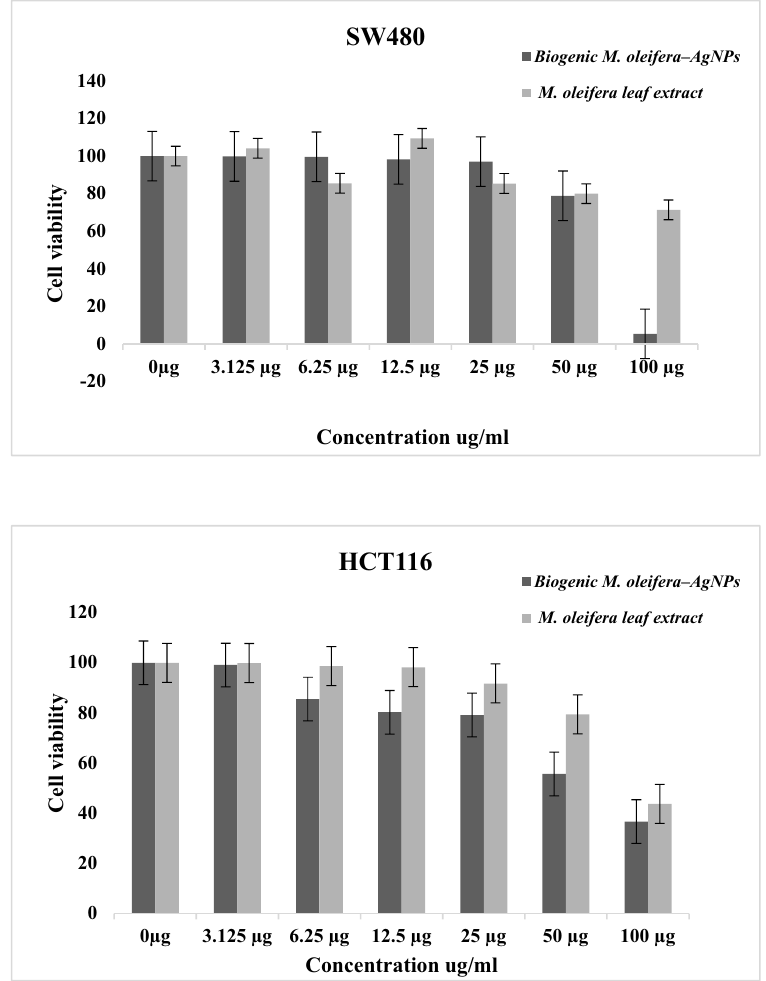
Figure 6: Cytotoxicity of M. oleifera leaf extract and green - synthesized M. oleifera – AgNPs on the SW480 and HTC116 human colon - cancer cell lines following 24 h